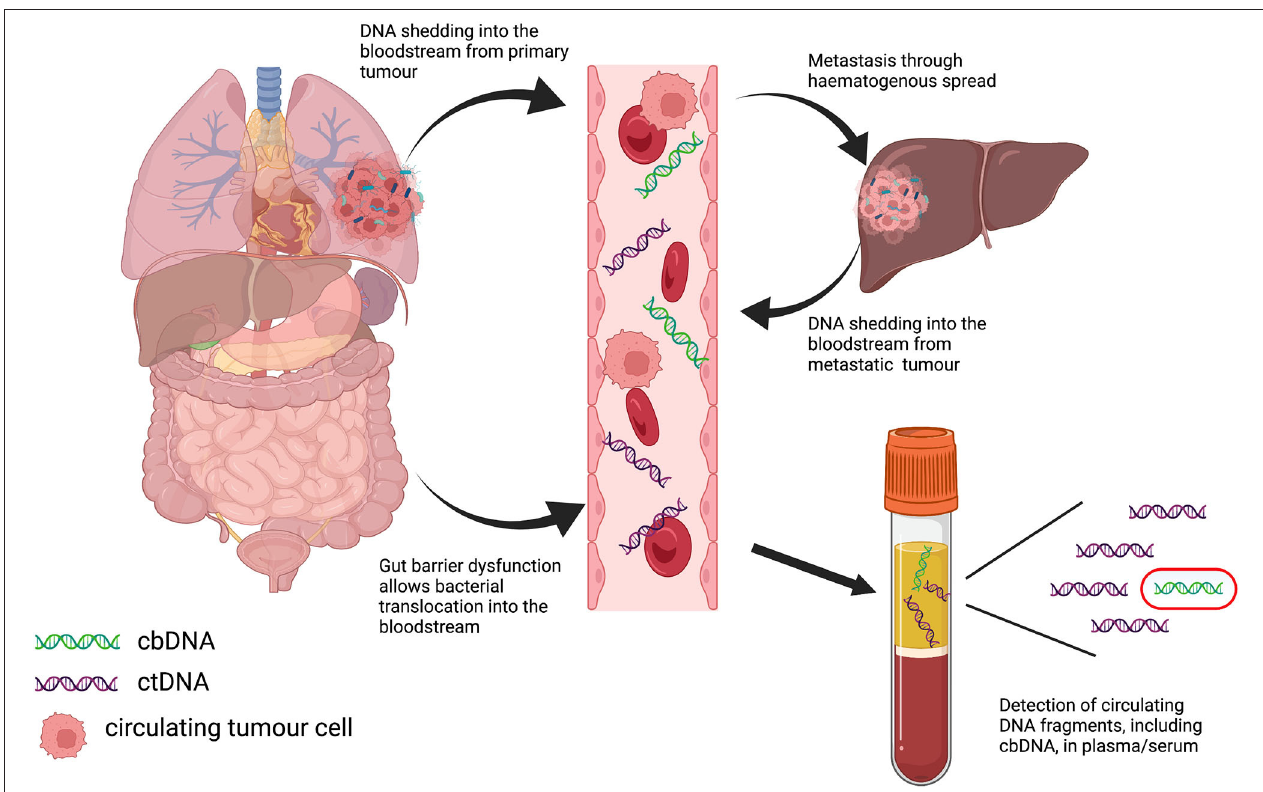
FIGURE 1 | Graphical depiction of potential routes of translocation of bacterial DNA into the bloodstream in cancer, and subsequent detection in plasma samples.